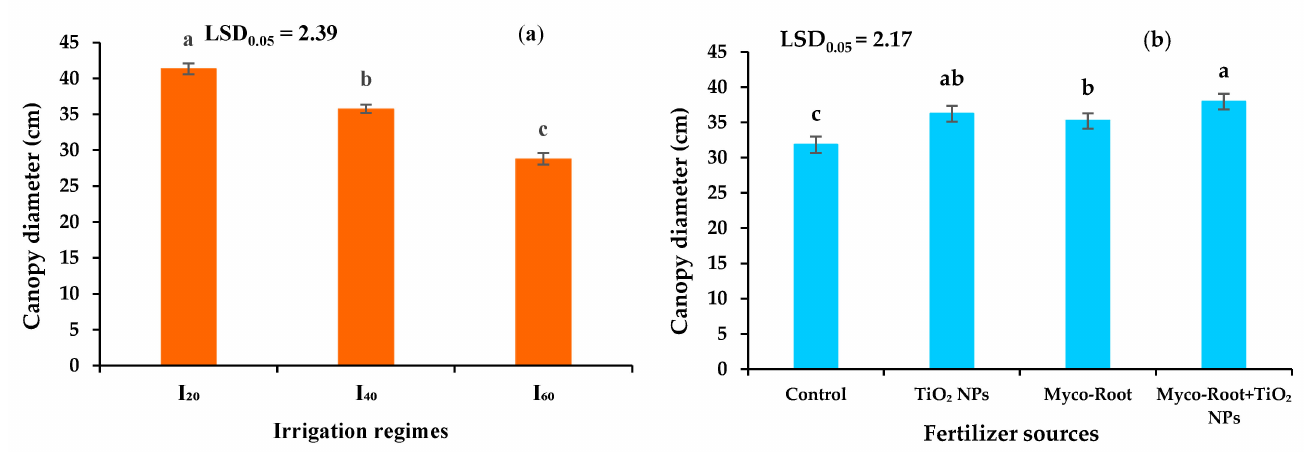
Figure 3. The effects of different irrigation regimes ( a ) and fertilizer sources ( b ) on the canopy diameter of peppermint. I 20 , I 40 , and I 60 indicating well-watered, mild, and severe drought stress, respectively. Different letters indicate significant differences at the 5% level according to LSD’s